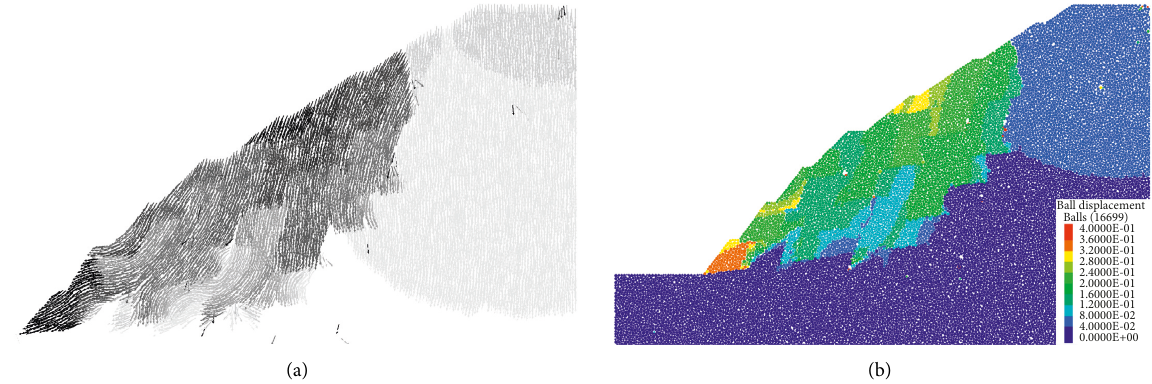
Figure 11: Particle displacement diagram: (a) vector image and (b) cloud map.